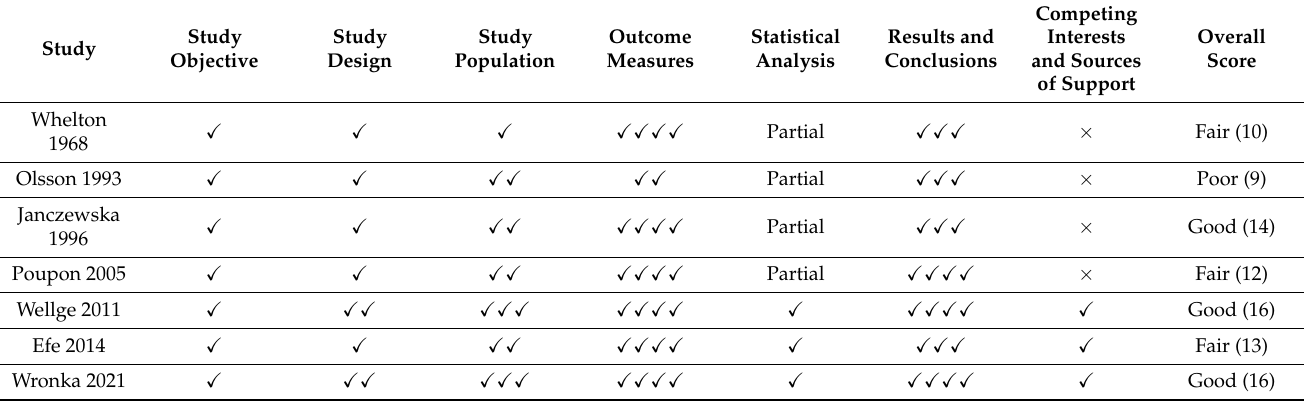
Table 7. Quality assessment of individual case series studies using the IHE Quality Appraisal